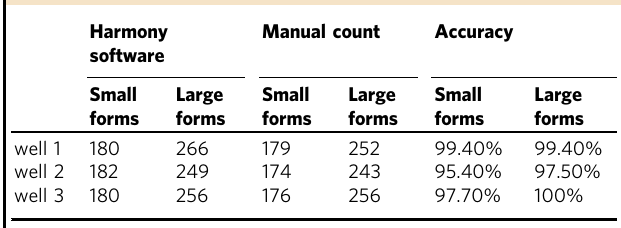
Fig. 5 Enhanced-throughput imaging and analysis for PE therapeutic screening. Schematic represents automated imaging and data analysis work fl ow using the Operetta high-content imaging (HCI) system (Perkin Elmer) where four consecutive steps are followed for maximum throughput of liver stage (LS) screening. Step 1: fl uorescent channels are selected based on secondary conjugates and imaging parameters are set based on ×20 magni fi cation (0.4 NA). Step 2: LS parasites are identi fi ed by high intensity staining patterns of LS-speci fi c antibody (i.e., anti-rUIS4 for P . vivax or anti-GAPDH for P . falciparum ) denoted by line plot pro fi le (1, 2) Step 3: LS parasites are further characterized into size categories by area and roundness to ensure software is correctly selecting the entire parasite. Step 4: After LS parasites are quanti fi ed, raw data is imported into CDD vault or Graphpad Prism where % inhibition and dose- response curves are calculated based on total parasites and size. P . vivax LS assays speci fi cally determine compound activity on hypnozoite population. White scale bars represent 5 µ m Table 2 Comparison of P . vivax liver stage (LS) parasite quanti fi cation: Operetta vs.